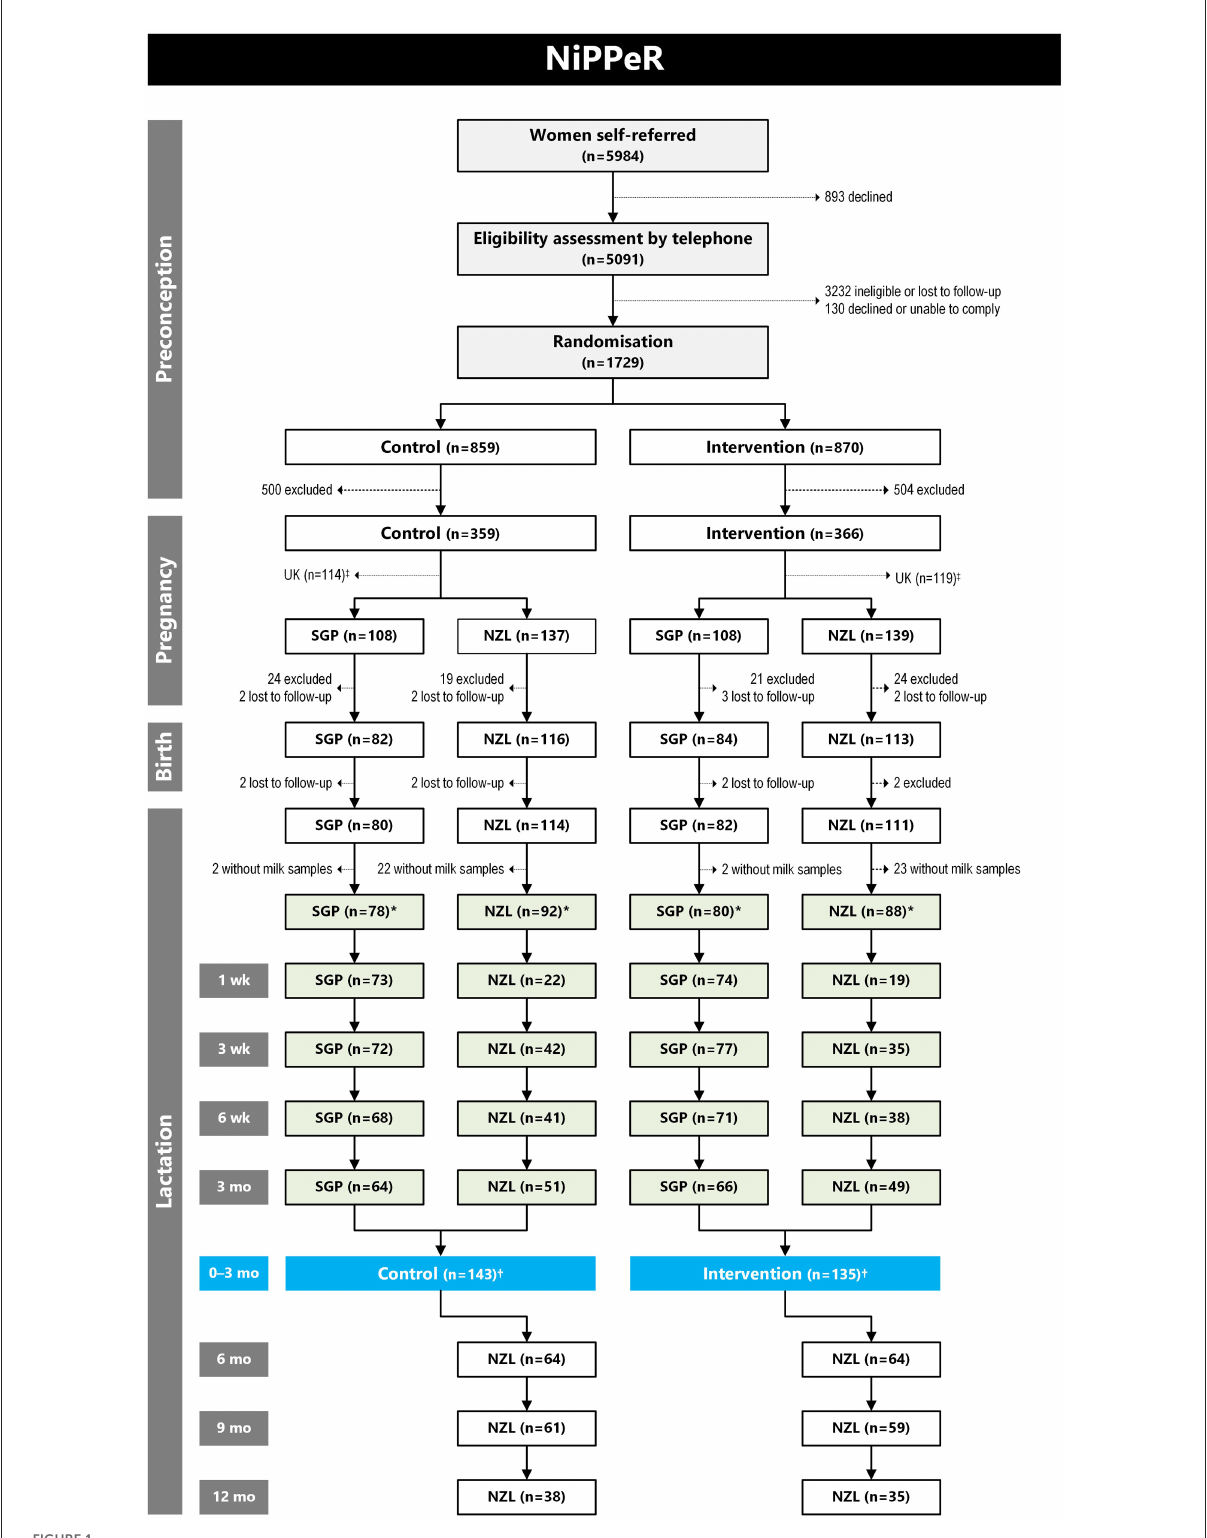
FIGURE1 CONSORT diagram for number of human milk (HM) samples analyzed for mineral concentrations in the NiPPeR study. Reasons for exclusion during the preconception phase have been published previously (27), while reasons for exclusion during pregnancy and birth in Singapore (SGP) and New Zealand (NZL) are provided in Supplementary Table 2. There were no HM samples collected in the United Kingdom (UK), so all participants from that site were excluded from this diagram. *Number of participants who provided at least one HM sample during 12 months of lactation. † Number of participants who provided at least one HM sample during the first 3 months of